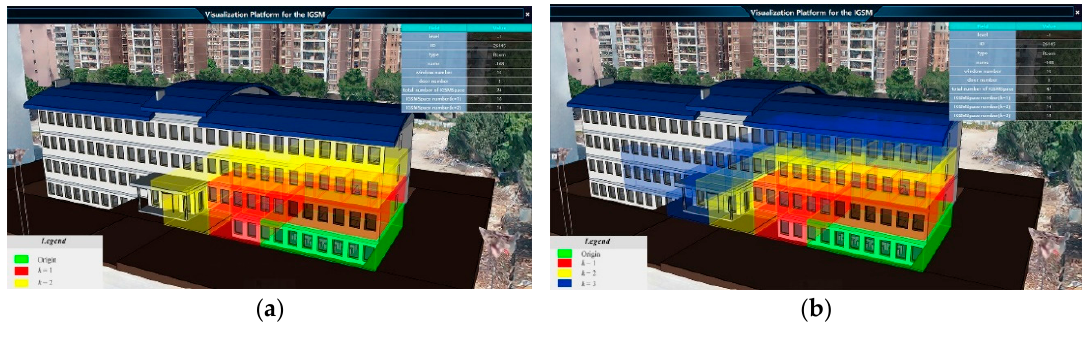
Figure 18. Result of K-adjacent analysis in the virtual globe (sample data from Table 2. Office Building). ( a ) Result of 1-adjacent analysis. ( b ) Result of 2-adjacent analysis.